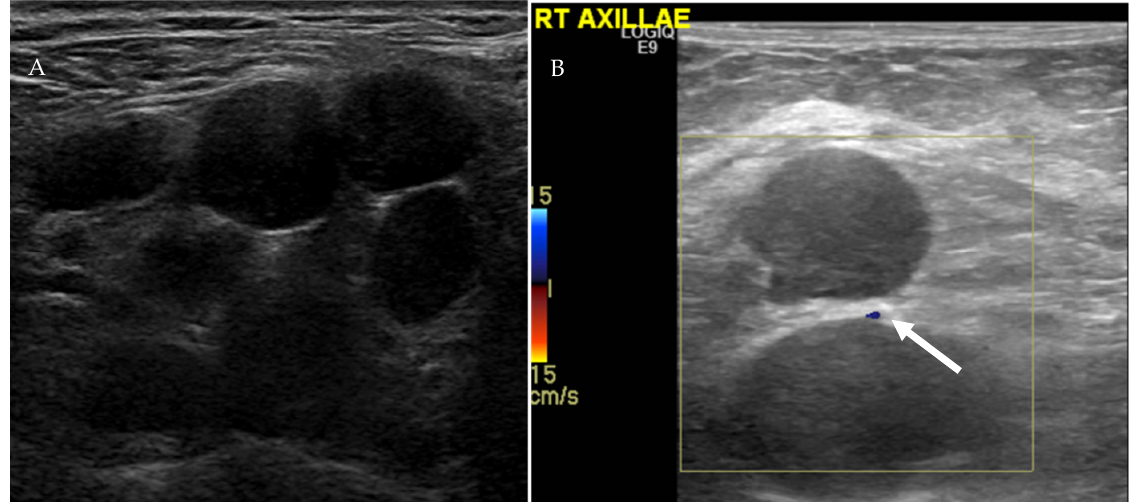
Figure 9. Ultrasound of the right axilla ( A ) demonstrates multiple, round, and hypoechoic metastatic lymph nodes with S/L axis ratio of approximately 1 and lack of the echogenic fatty hilum. Color Doppler ultrasound of the axillary lymph ( B ) nodes shows peripheral vascularity (arrow).